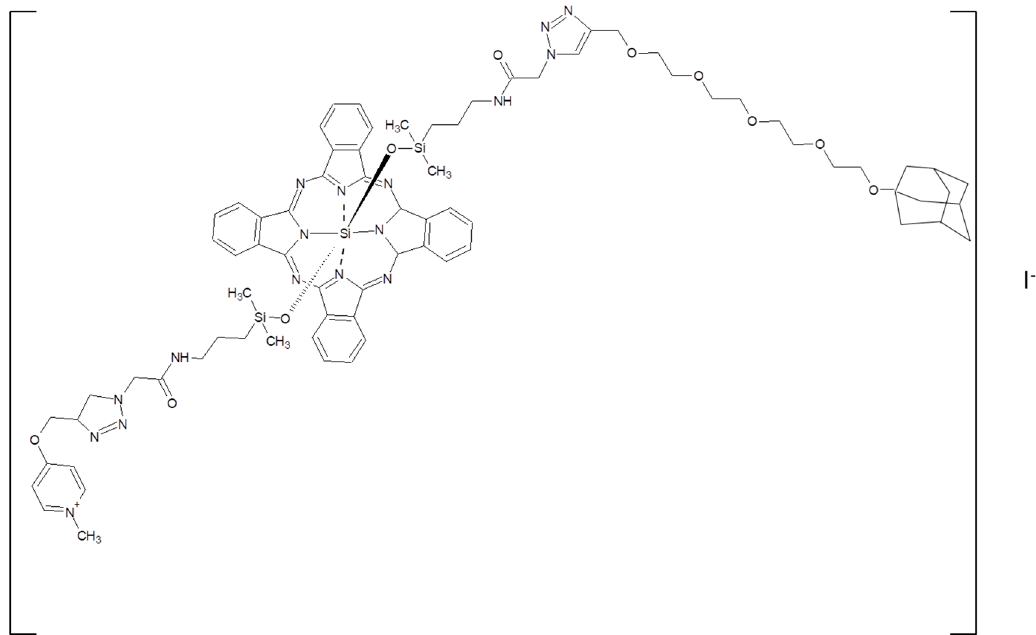
Figure 27. Chemical structure of Si(IV)Pc derivative modified with an axial pyridinium and an axial adamantane moiety used in ref [146].